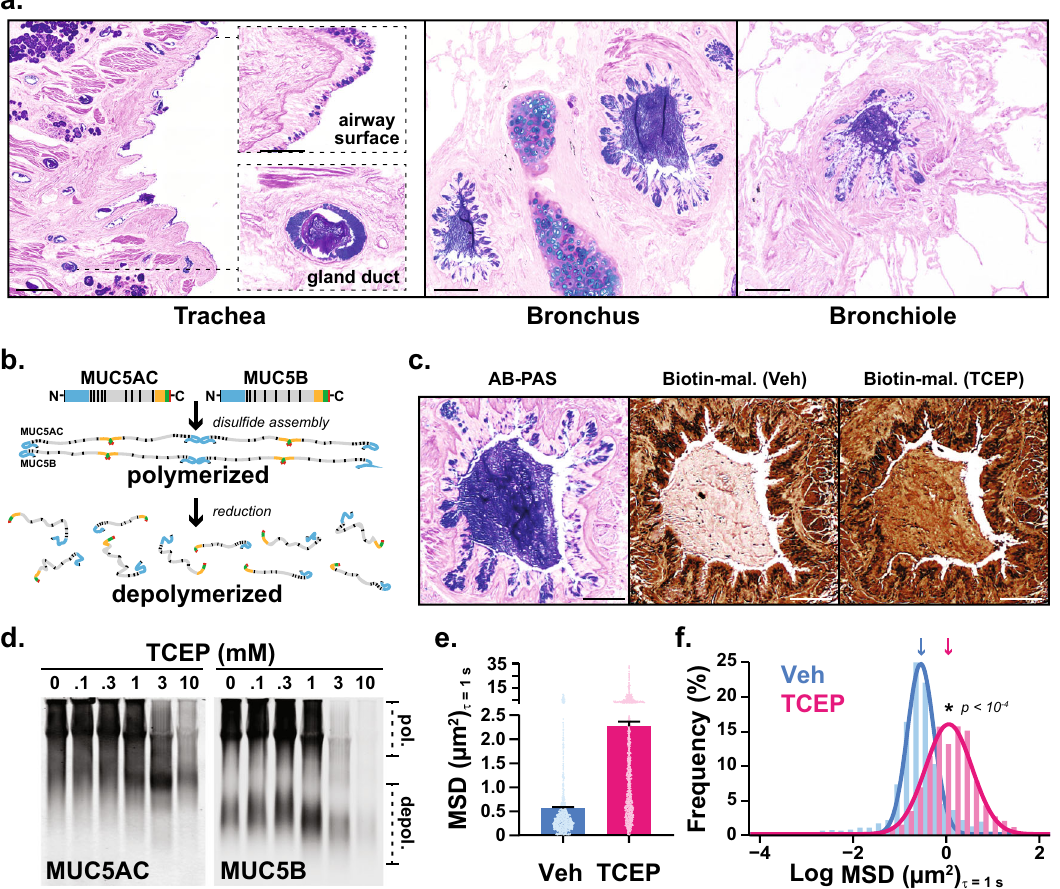
Fig. 1 Polymeric mucins in asthmatic airways are targets for disul fi de disruption. a Alcian blue/periodic acid-Schiff (AB-PAS) stained tissues from the lungs of patients ( n = 2) who died during asthma exacerbations demonstrate mucin glycoproteins in large and small airways. Scale bars, 500 μ m and 100 μ m in insets (trachea), 200 μ m (bronchus and bronchiole). b MUC5AC and MUC5B assemble via amino (N-) and carboxyl (C-) terminal disul fi de bonds that are sensitive to reducing agents. c A mucus plug in a fatal asthma airway was examined in consecutive sections stained with AB-PAS (purple), or labeled with biotinylated- maleimide (brown) after incubation at 37°C for 10min with saline vehicle (Veh) or tris(2-carboxyethyl)phosphine (TCEP, 10mM). Scale bars, 250 μ m; image representative of airways from n = 2 patients. d – f . Expectorated sputum ( n = 3 patients) was treated with TCEP (0.1 – 10mM, 37°C, 30min), separated by electrophoresis (1% SDS/agarose, non-reducing), and detected by immunoblot for MUC5AC and MUC5B ( d ). Note that full reduction causes epitope loss for both anti-mucin antibodies resulting in decreased signal intensities at higher TCEP concentrations in d . Diffusion of 2- µ m carboxylated micro-particles was evaluated in mucus samples aspirated from fatal asthma bronchi ( e , f ). Compared to vehicle controls (Veh, cyan, n = 1303), particle mean square displacement (MSD) increased signi fi cantly after TCEP (magenta, n = 1425). Bars in e are means ± sem of summarized linear-scale values, with individual points (open circles). Data in f are log distributions of particles with curves showing Gaussian non-linear fi ts ( r 2 = 0.99 for Veh and TCEP). Signi fi cance was determined by two-tailed Mann – Whitney U -tests with p -value and “ * ” denoting signi fi cance from Veh in f . Inverted arrows in f indicate locations of median values. Source data are provided as a Source Data fi